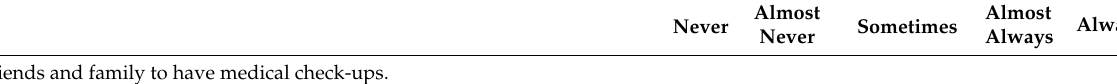
Table A1. Generativity Relative to Health (GeReH) (90 Item Version) Below is a series of statements about what you feel, think or do, please indicate how often you think you carry out each of them in a range that goes from 1 to 5 considering that: 1 = Never, 2 = Almost never, 3 = Sometimes, 4 = Almost always, and 5 = Always. Your answers are very important, so we ask you to respond truthfully knowing that there are no right or wrong answers and that the information you share